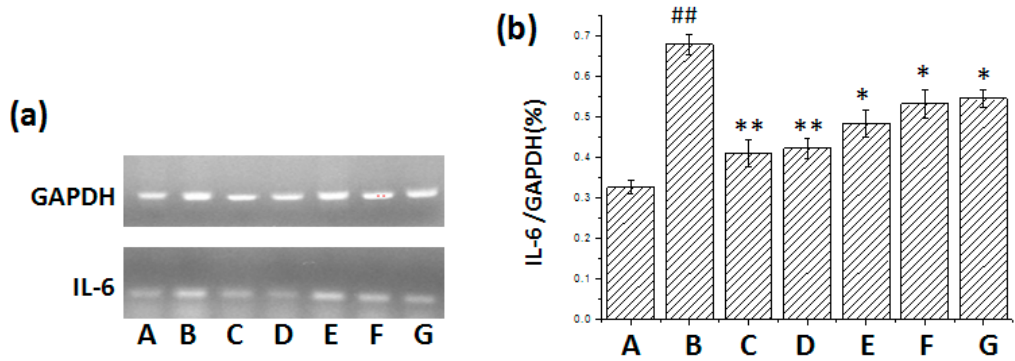
Figure 3. Effect of m KG on the mRNA Expression of IL-6 in the lung tissues of BLM-induced pulmonary fibrosis mice. ( a ) The mRNA expressions of IL-6 in the lung tissues were detected by RT-PCR; ( b ) The semiquantitative result of the IL-6 mRNA expression. Data were expressed as mean ± S.D. ## p < 0.01 compared with the control group. * p < 0.05, ** p < 0.01 compared with the BLM group. (A) Normal group; (B) BLM group; (C) Pirfenidone group; (D) Dexamethasone group; (E) m KG-H group; (F) m KG-M group; (G) m KG-L group.